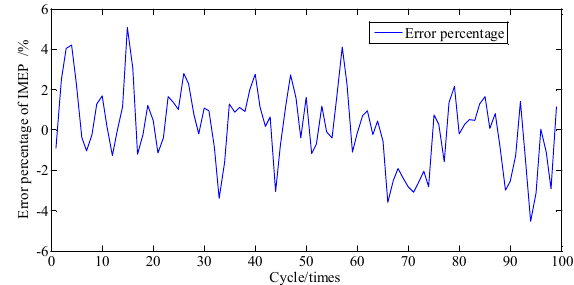
Figure 20. Error percentage of IMEP at A/F ratio 0.95 per cycle.